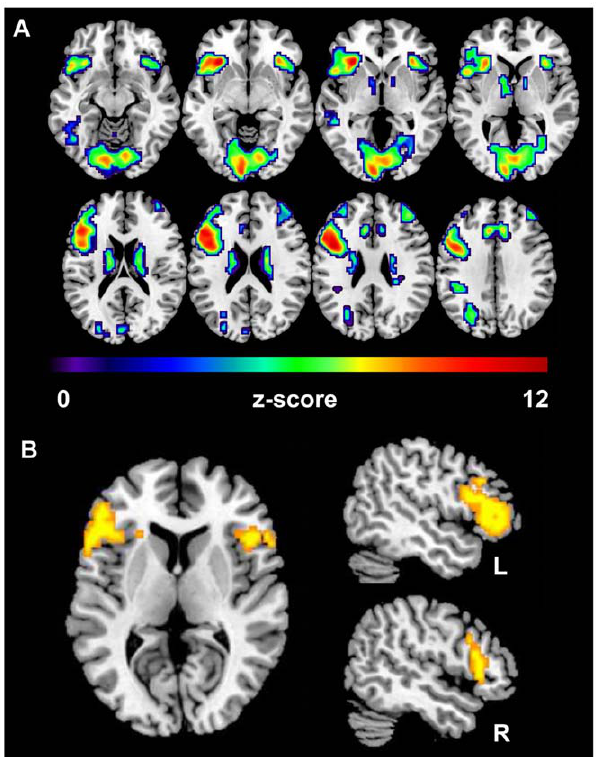
Figure 2. Results of the whole brain analysis. (A) Illustrates activity patterns across tasks, difficulty levels, and age-groups compared to baseline activity levels (p=.01, FWE corrected), and (B) the two clusters in the vIFG that responded to the task difficulty manipulation (p=.005, uncorrected); left=left.